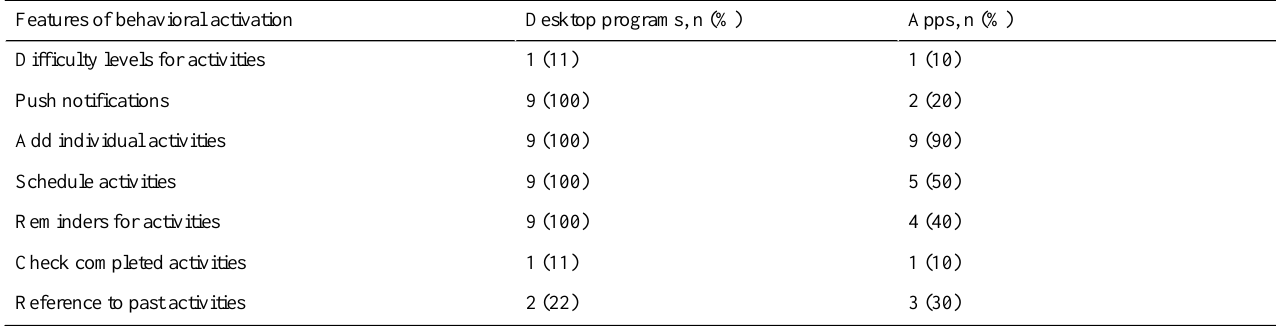
Table 5. Absolute numbers and relative share of web-based interventions addressing specific features of behavioral activation in desktop programs (N=9) and apps (N=10).